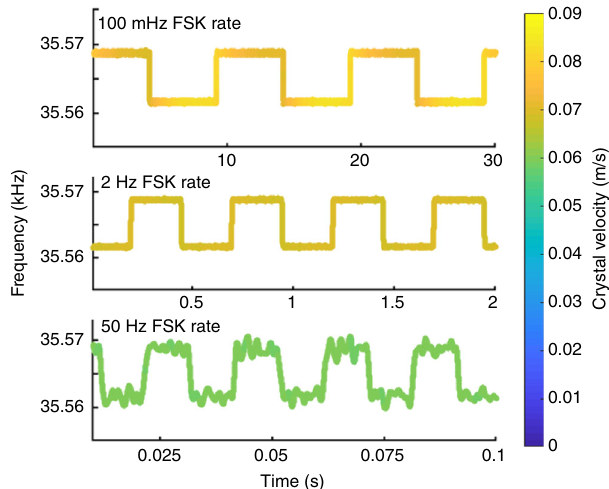
Fig. 6 Measured crystal velocity for three different frequency shift keying (FSK) rates using direct antenna modulation. The two frequencies are clearly distinguishable for all rates and the velocity magnitude decreases only slightly from about 0.07 m/s peak at 100 mHz to about 0.06 m/s peak at 50 Hz Finally, a lathe was used to polish the rod using a 1- μ m aluminum oxide slurry and a polyurethane pad. Each metalized end of the LN rod has a 0.003 inch copper wire bonded to the surface via structural epoxy and silver paint. On one end, the thin wire attaches to the input signal. On the other end, the wire attaches to a fi eld shaping toroid. Using this common high-voltage design technique, the toroids are at or near the potential of the LN rod corners and therefore spatially distribute the equipotential lines. This decreases the peak surface electric fi eld on the LN for a given dipole moment, thereby increasing the achievable dipole moment prior to high voltage fl ashover. The toroids on either end of the LN are mechanically supported by alumina posts and do not contact the LN rod. The LN is suspended by two fused silica rods located at the longitudinal center of the LN rod. The fused silica rods are supported by vertical alumina rods (see supplementary Fig. 4). For tests in the vacuum chamber, the pressure is kept to less than 2 ×10 − 7 Torr. To measure the crystal velocity, a Polytek OFV-5000 with OFV-552 sensor head laser Doppler vibrometer shines on one end of the LN rod. In laboratory tests, the NATURE COMMUNICATIONS| (2019) 10:1715